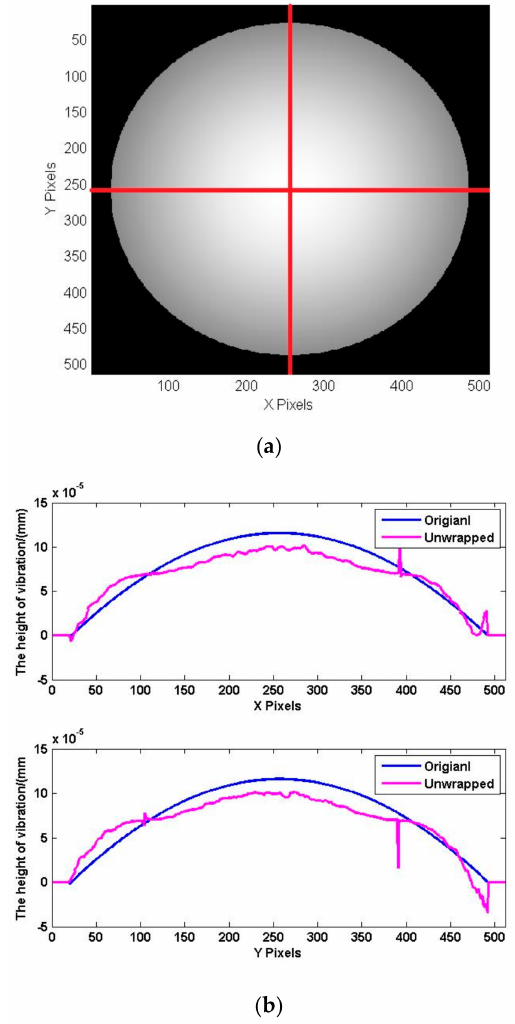
Figure 12. Phases of deformation. ( a ) Profile data; ( b ) data